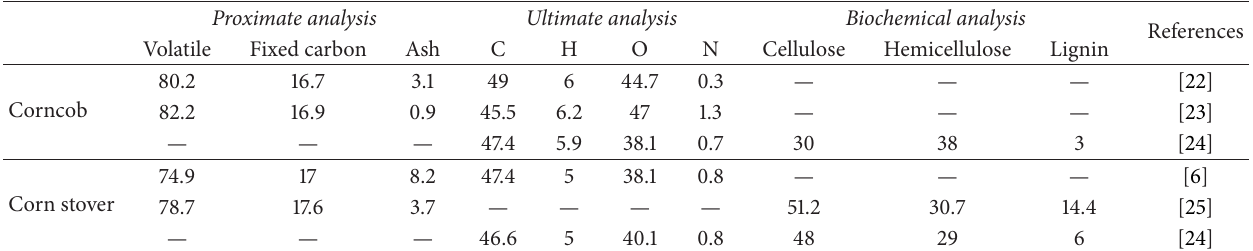
Table 1: Properties of corncob and stover on a dry basis. Proximate